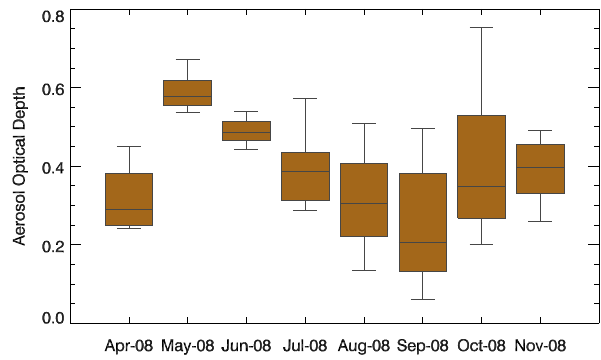
Fig. 8. Aerosol optical depth at 500nm over Gadanki.